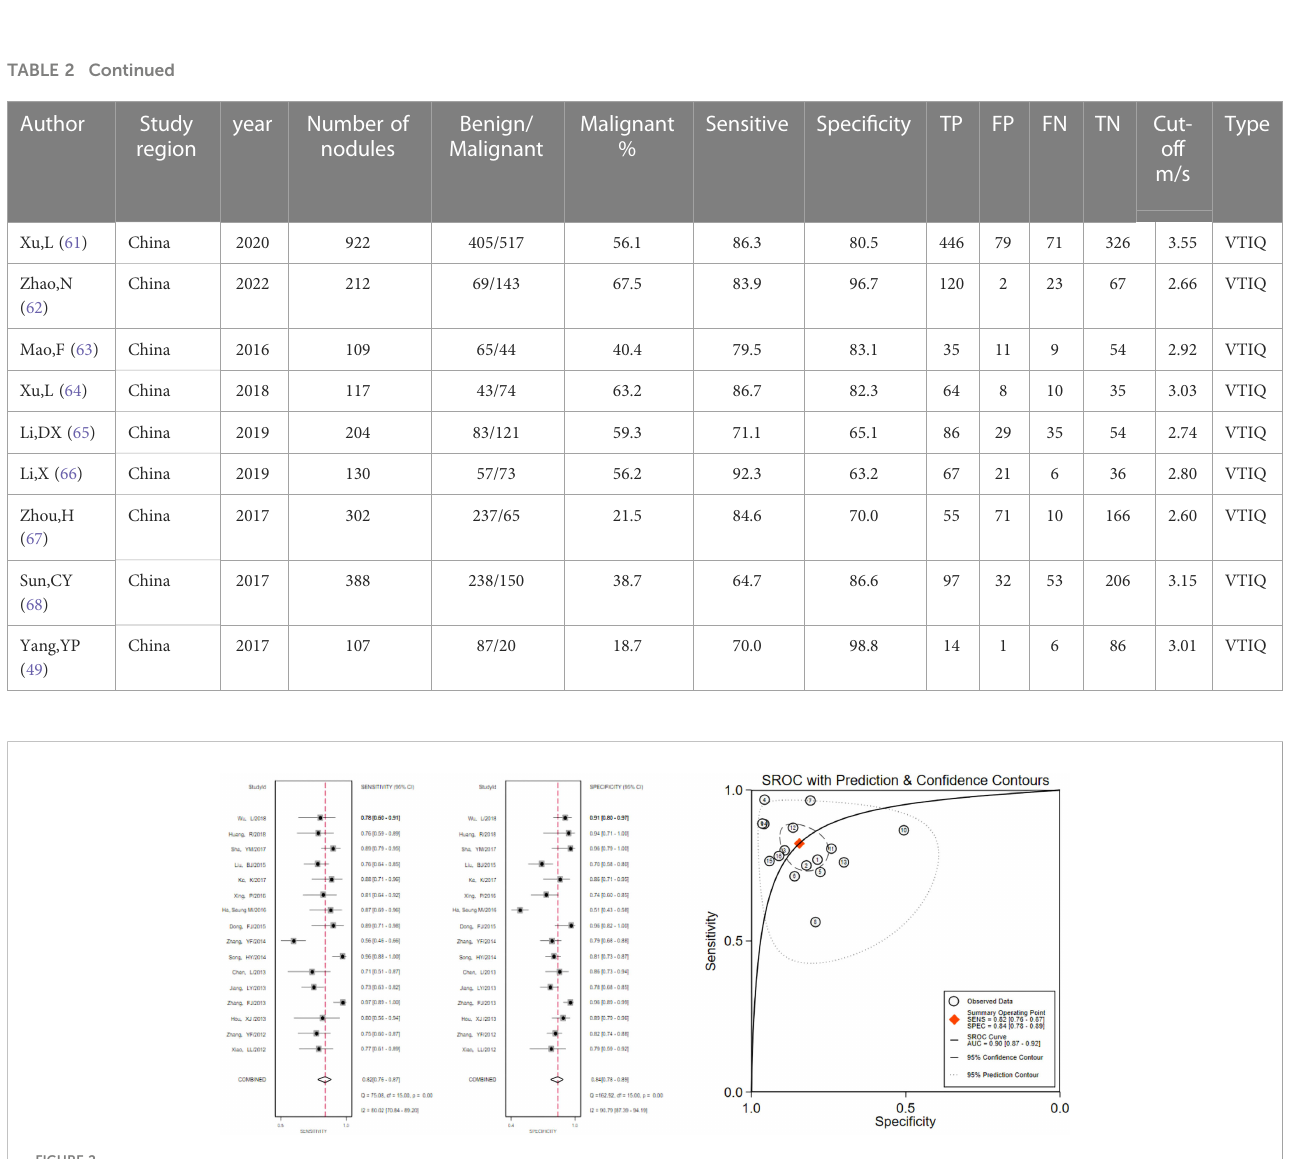
FIGURE 2 The sensitivity and speci fi city of the A VTQ group in the diagnosis of thyroid nodules and the summary ROC (Summary ROC) curve of the A VTQ group were analyzed. the AUC indicates the area under the curve.